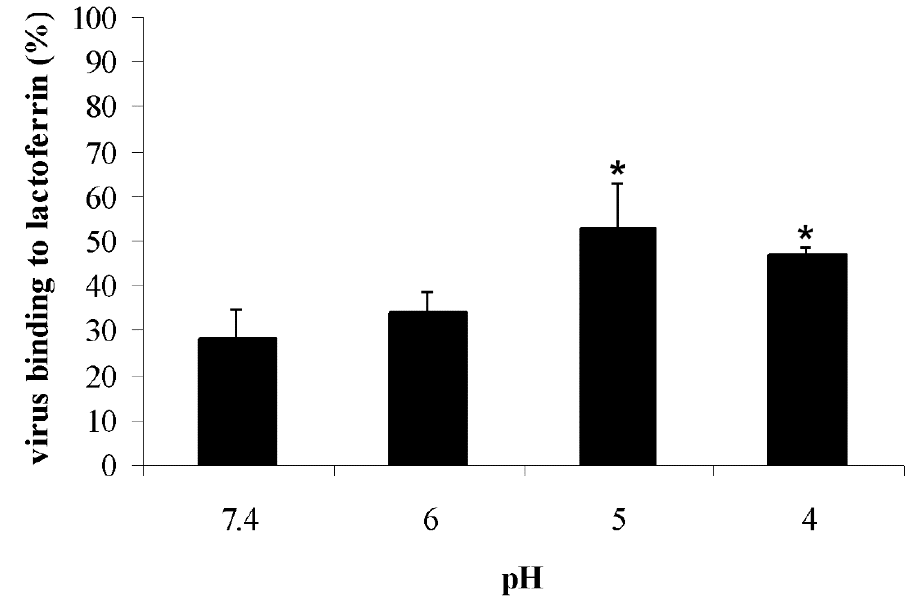
Figure 4. Influence of pH on influenza virus binding to bLf by ELISA. Virus samples incubated with buffers at different pH (from 7.4 to 4.0) were absorbed to bLf-coated plastic surfaces. The interaction between the different influenza virus samples and bLf was analyzed by an enzyme-linked immunosorbent assay, and results were expressed as the percentage of virus binding to bLf. Error bars represent the mean of three independent experiments. * p < 0.05.